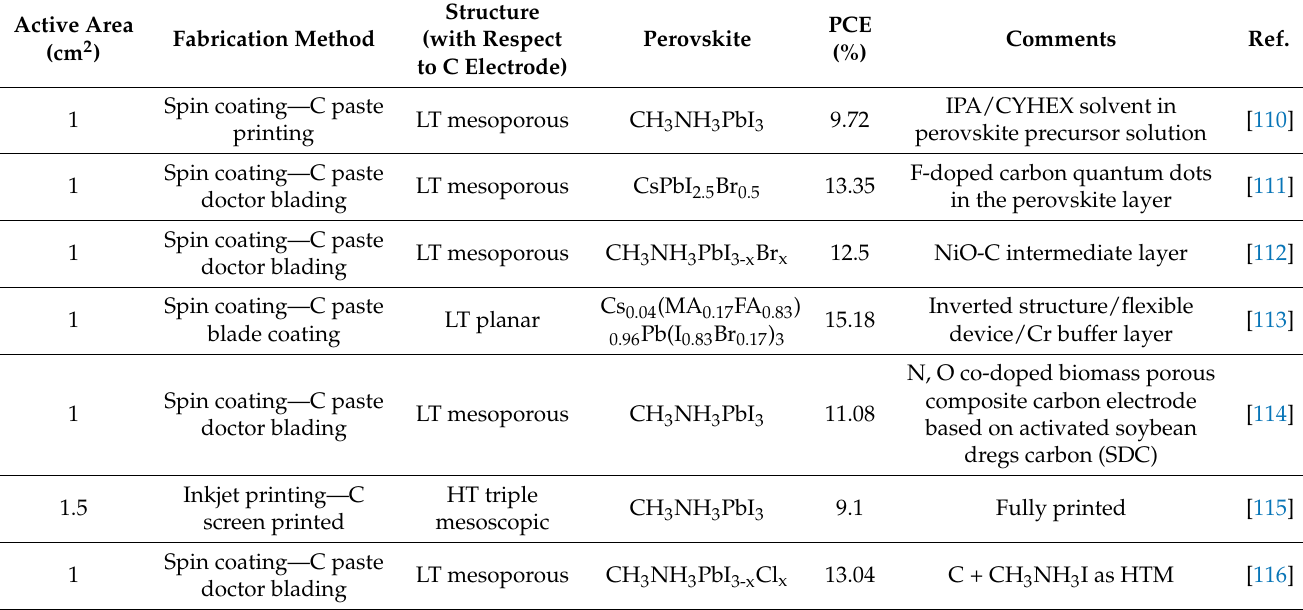
Table 3 . Summary of the highest PCEs obtained so far in PSCs employing a C electrode with active area 1–3.5 cm 2 .